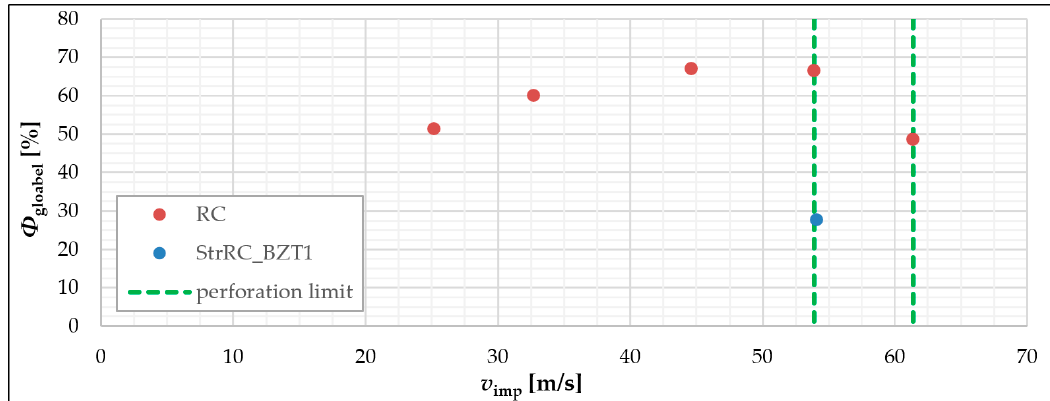
Figure 13. Representation of the global damage ( Φ global ) in relation to the impactor velocity ( v imp ); graphic: Hering [17].